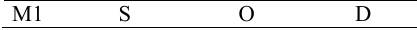
Table 7. The evaluations of experts in